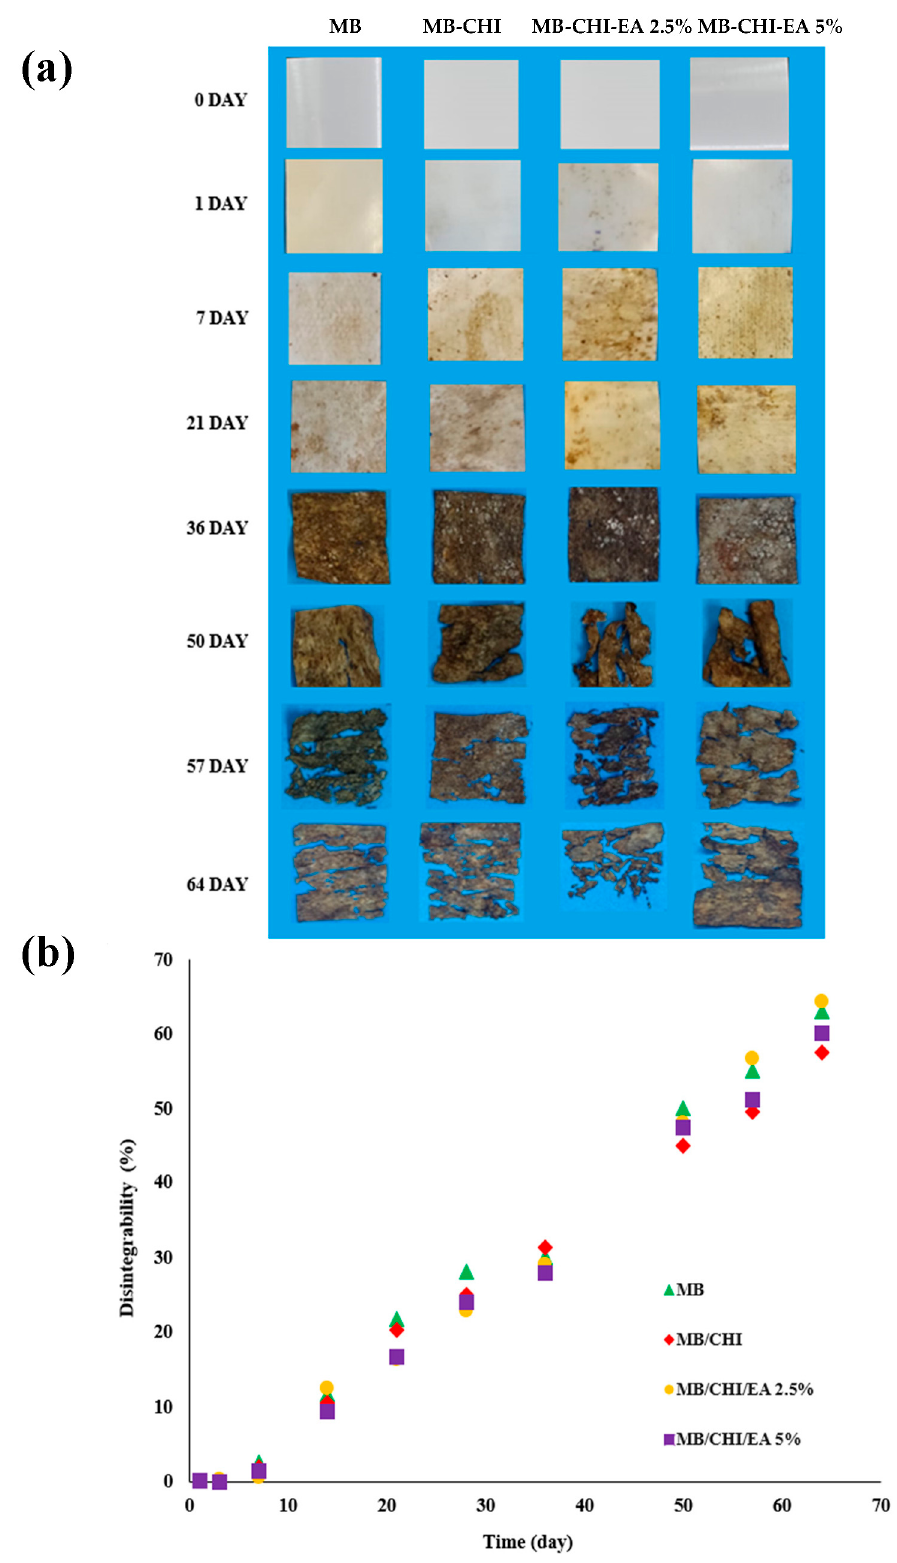
Figure 5. ( a ) Visual appearance of developed materials at different times under composting condi- tions; ( b ) film disintegration degree under composting conditions as a time function.